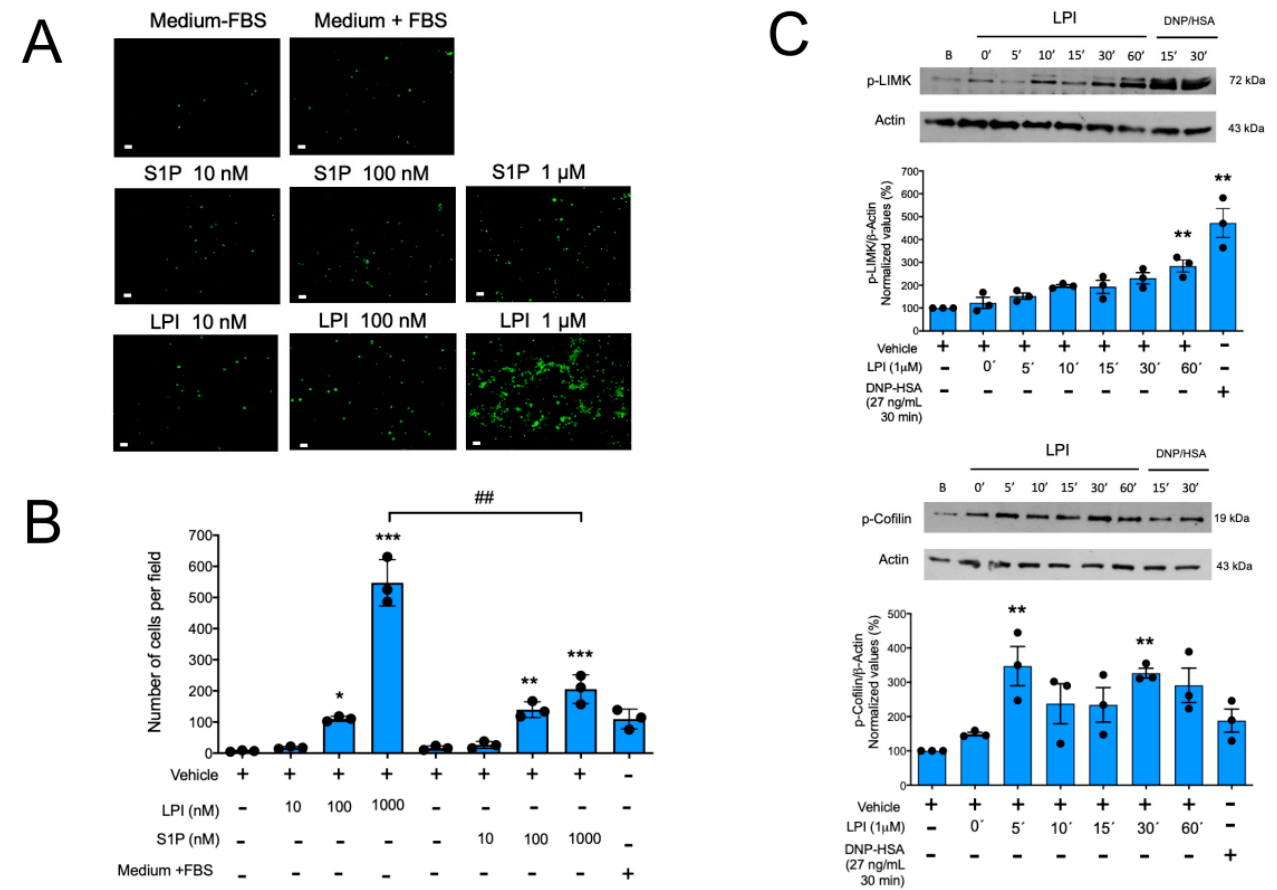
Figure 1. LPI promotes chemotaxis and changes on the LIMK/cofilin axis in MCs. Panel ( A ): representative image of a filter obtained in a migration assay of BMMCs towards distinct chemoattractants in the Boyden’s chamber. Scale Bar = 20 µ m. Panel ( B ): quantification of migration of MCs towards sphingosine 1 phosphate (S1P) and lysophosphatidylinositol (LPI) is shown. Chemoattractants were dissolved first in a proper vehicle and then in serum-free media (Materials and Methods). Data are presented as the mean ± SEM of the number of cells observed in at least four microscope fields obtained with the 10 × objective, from three independent experiments performed with distinct cell cultures, * p < 0.05; ** p < 0.01; *** p < 0.001 vs. vehicle; ## p < 0.01 vs. LPI. Panel ( C ): two million BMMCs were stimulated with 1 µ M LPI during the indicated times, and then lysed to detect phos- phorylation of LIMK and cofilin proteins by Western blot with specific antibodies. A representative gel image and the quantification of band intensity observed in at least three independent experiments are shown. ** p < 0.01; *** p < 0.001 vs.